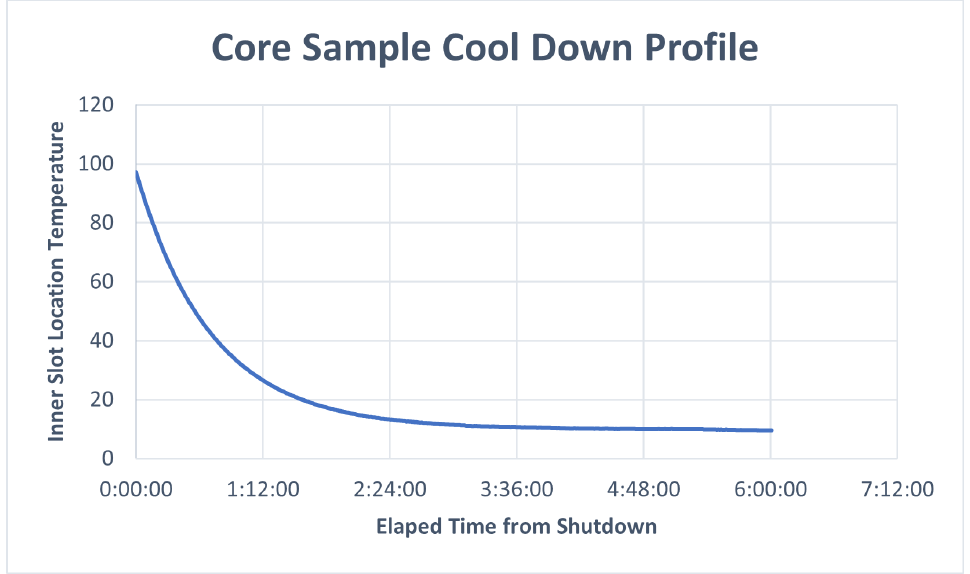
Figure 16. Core sample configuration cool down profile.